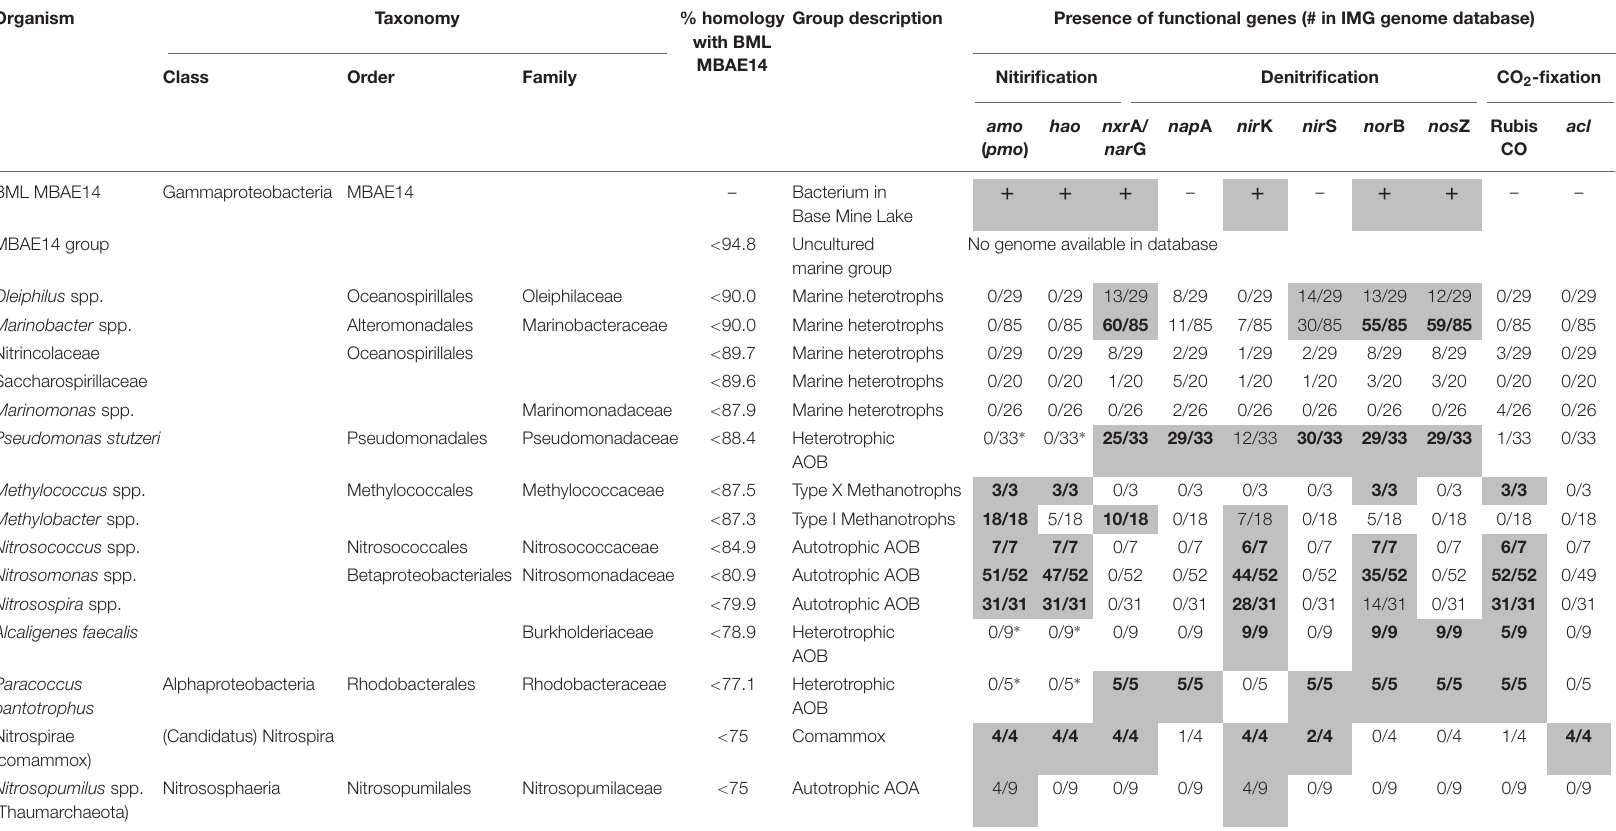
Presence of functional genes is shown in gray (present in > 30% of the reference genomes of each bacterial group in IMG database; bold, > 50%). ∗ Putative genes (not homologous) and enzymes were previously sequenced or purified. amoA (pmoA), ammonia monooxygenase (ammonia → hydroxylamine) (methane → methanol); hao, hydroxylamine oxidoreductase (hydroxylamine → nitrite); nxrA/narG,